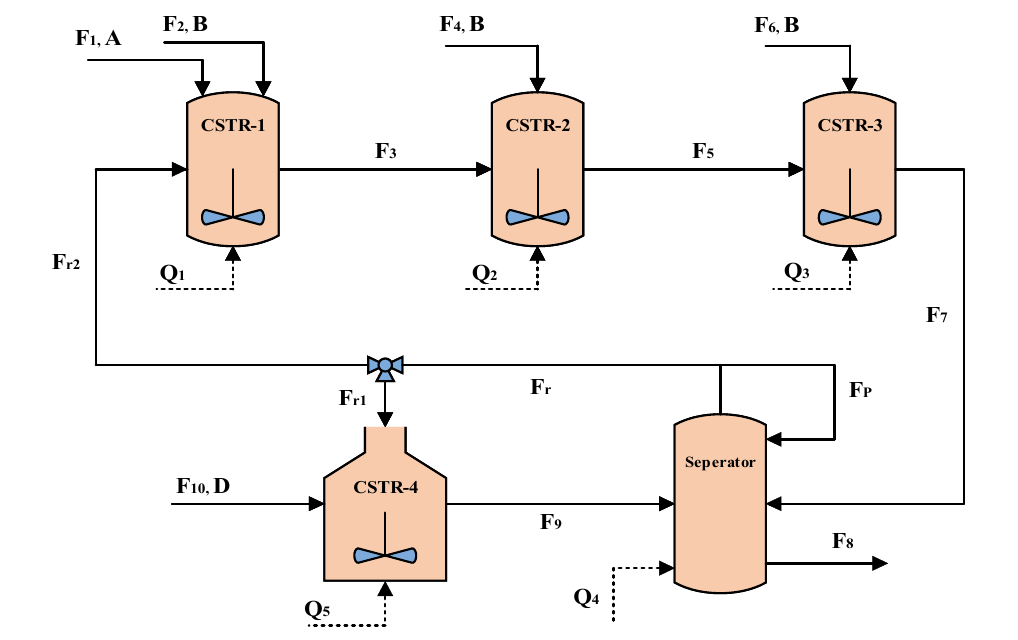
Figure 3. Flow diagram of alkylation of benzene process. Table 1. Process variables of the alkylation of benzene